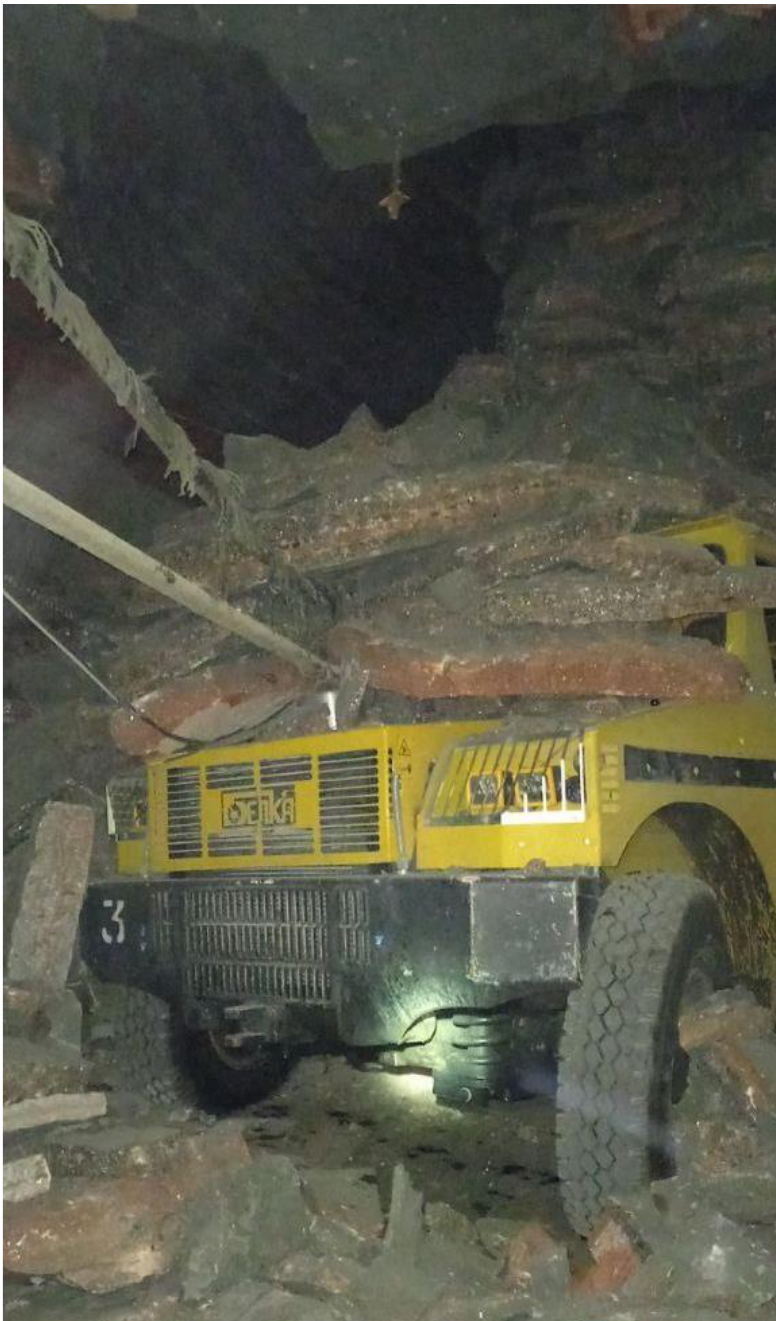
Figure 1. Rockburst, accompanied by gas release from camera K2 where the vehicle turns around (Mine 3, Second potash